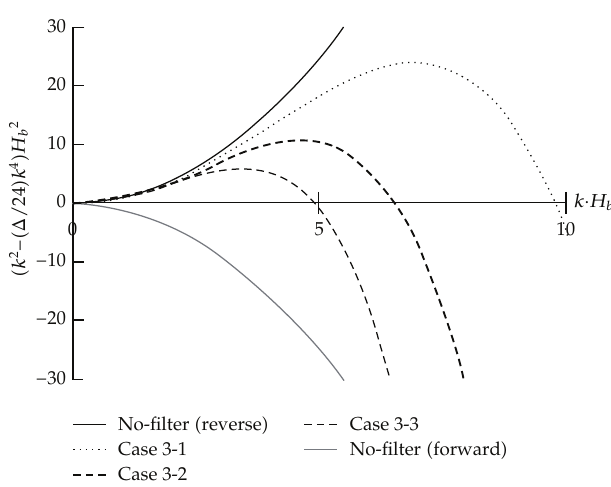
Figure 14: Coe ffi cients of right-hand side of (cid:3) 4.1 (cid:4) , (cid:3) 4.2 (cid:4) , and (cid:3) 4.4 (cid:4) in each wave number (cid:3) Case 3-1, Case 3-2, Case 3-3 (cid:4)